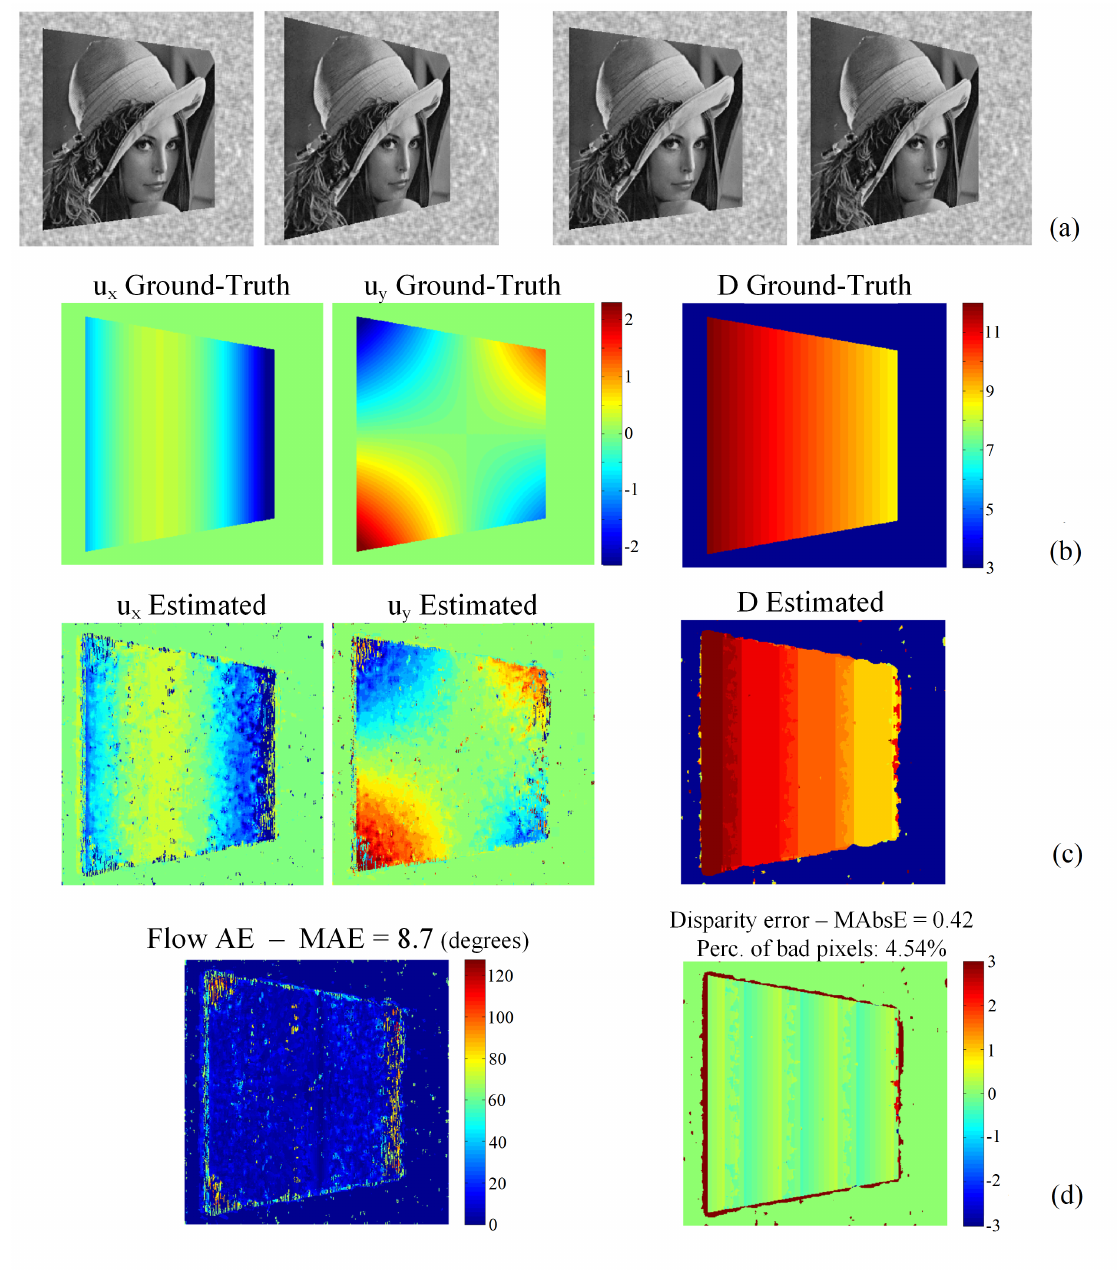
Figure 9. Artificial “Rotating Lenna plane” sequence: ( a ) the first and last (sixth) frame of the left and right views; ( b ) the ground-truth flow and disparity; ( c ) the corresponding estimated flow and disparity map; ( d ) the flow angular error and disparity